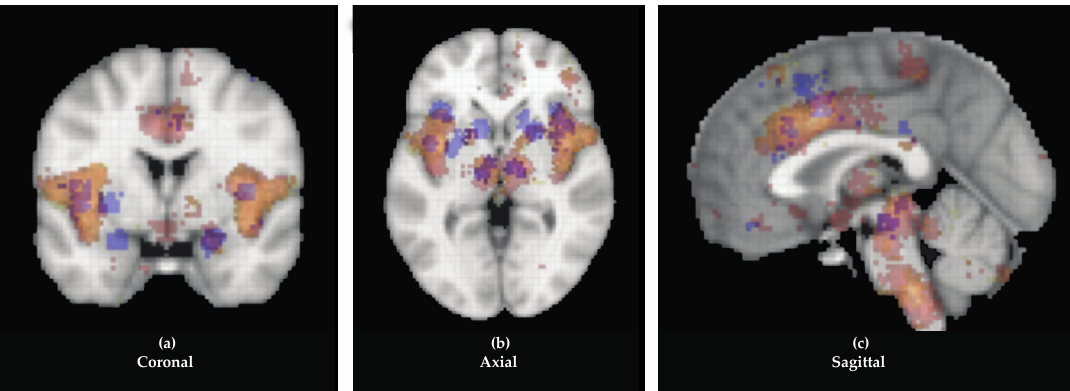
Figure 1. Overlay of three color-coded pain-related terms. “Chronic pain” is blue, “painful” is yellow, and “pain” is red. Functional magnetic resonance imaging (fMRI) studies of these terms are visualized in coronal ( a ), axial ( b ), and sagittal ( c ) axes from the Neurosynth database (neurosynth.org), showing consistent activation of the anterior cingulate cortex (ACC), thalamus, insula, and brainstem.